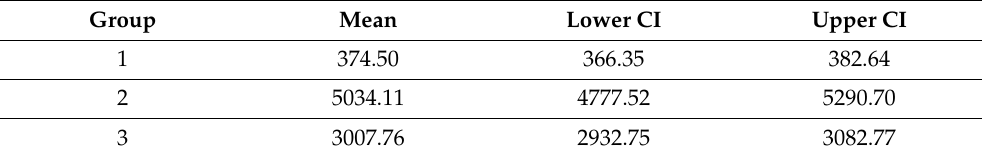
Figure 3. Comparison of antibody levels after full BNT162b2 vaccination by group according to the time factor and frequency of SARS-CoV-2 infection. Box and whisker plots are presented in turn: ( A ) the time elapsed after the full BNT162b2 vaccination; ( B ) evidence of SARS-CoV-2 infection before vaccination. Group 1 (dark blue box): 2 doses, more than 6 months before measurement, low antibody levels (<2500 BAU/mL), regardless of the declaration of prior COVID-19 infection. Group 2 (green box): 2 doses, more than 6 months before the measurement, high antibody levels (>2500 BAU/mL), no declaration of prior COVID-19 infection. Group 3 (yellow box): 3 doses, regardless of the declaration of prior COVID-19 infection and antibody level. Group 1 (purple box): a group of participants who did not meet the criteria for belonging to Groups 1, 2, or 3. Table 8. 95% confidence intervals (lower and upper bounds) for the mean level of antibodies in each of the three